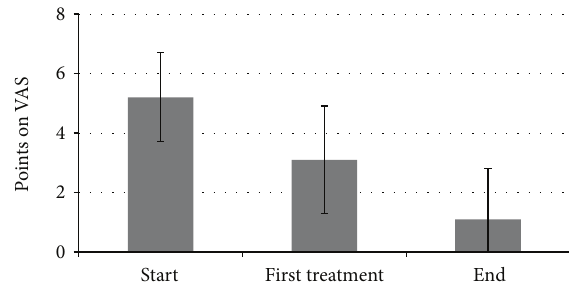
Figure 1: Score of pain in visual analogue scale.